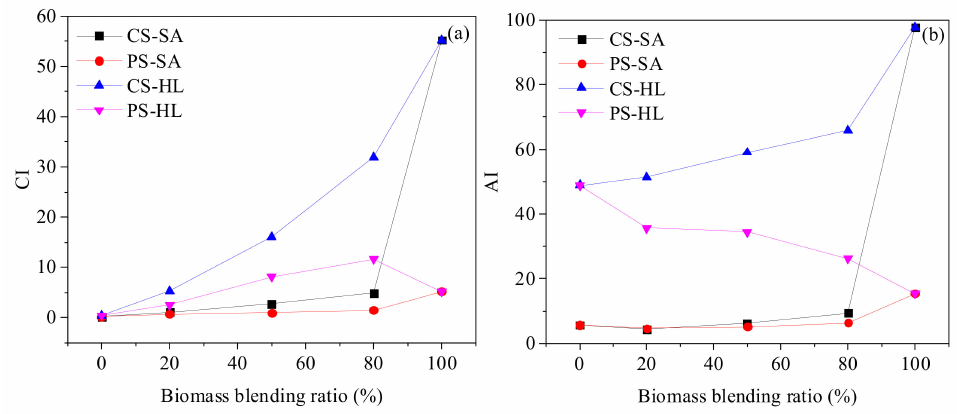
Figure 2. ( a ) CI and ( b ) AI of different char samples.